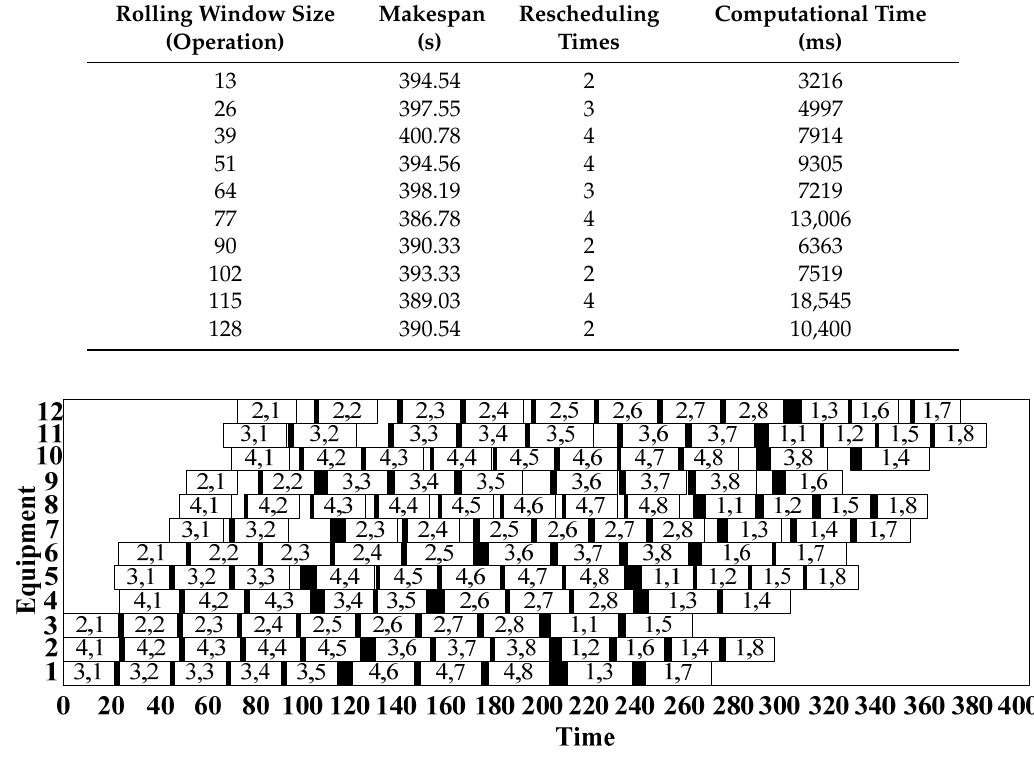
Table 4. Results of rolling window size experiments.